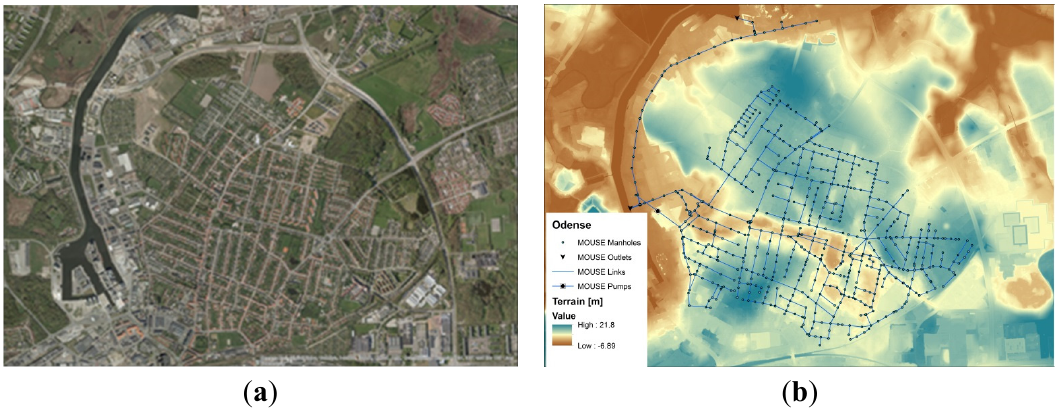
Figure 6. Study area located in Odense, Denmark. The area is a fully developed residential area with a combined sewer system. ( a ) shows an orthophoto while ( b ) shows the digital surface terrain as well as the sewer layout.